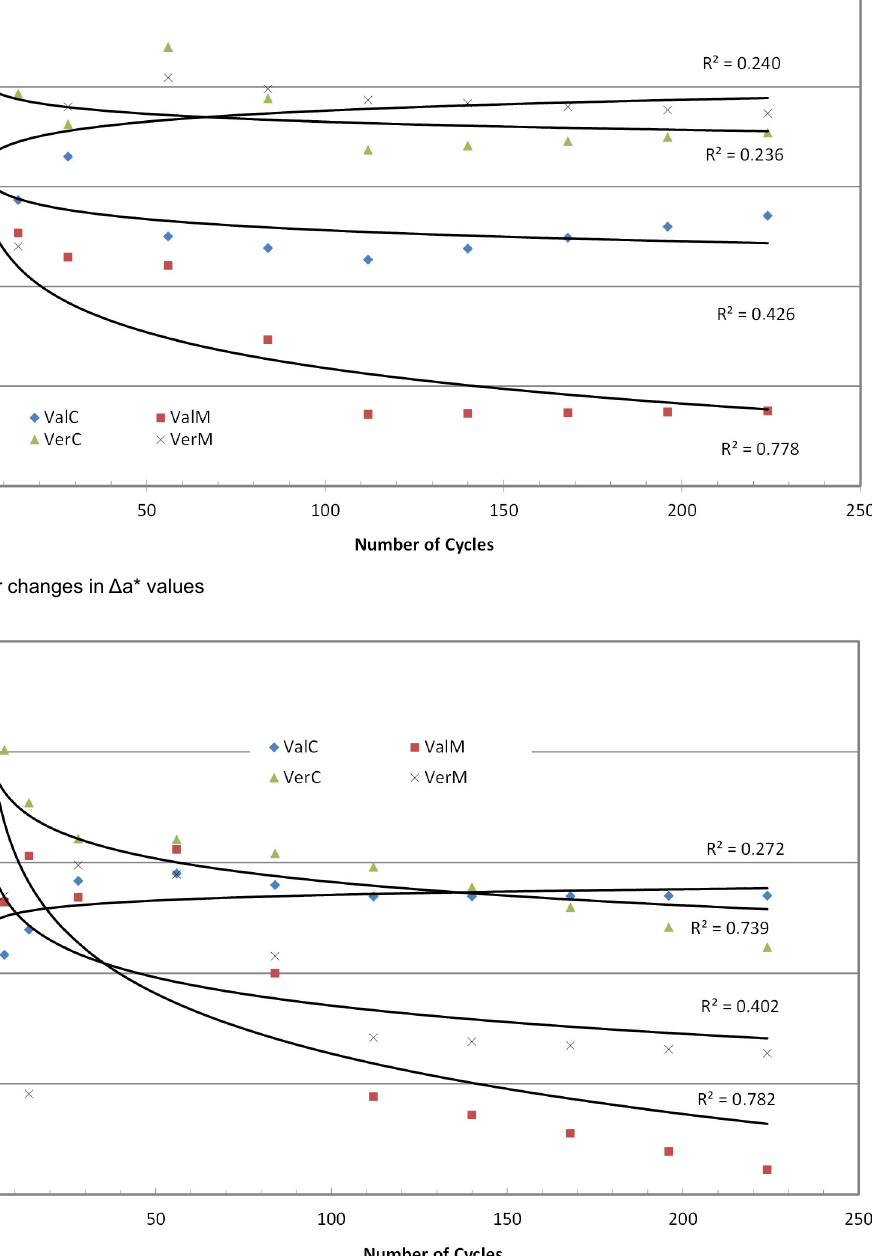
Figure 6- Trend lines for changes in Δb*